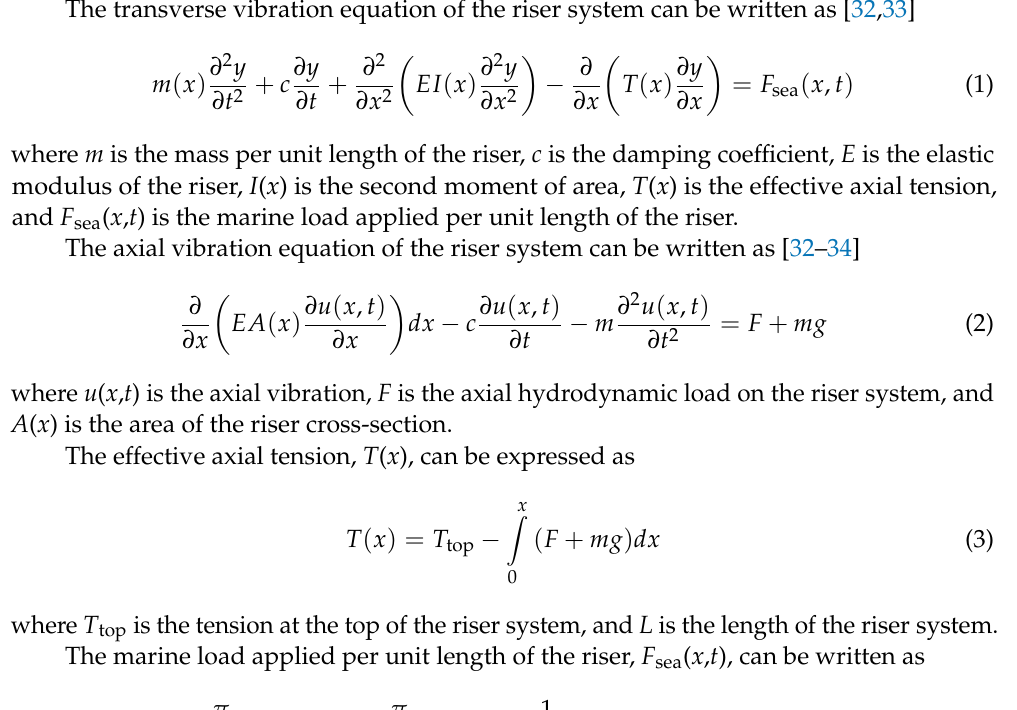
Figure 2. Deepwater drilling platform/riser coupling system.